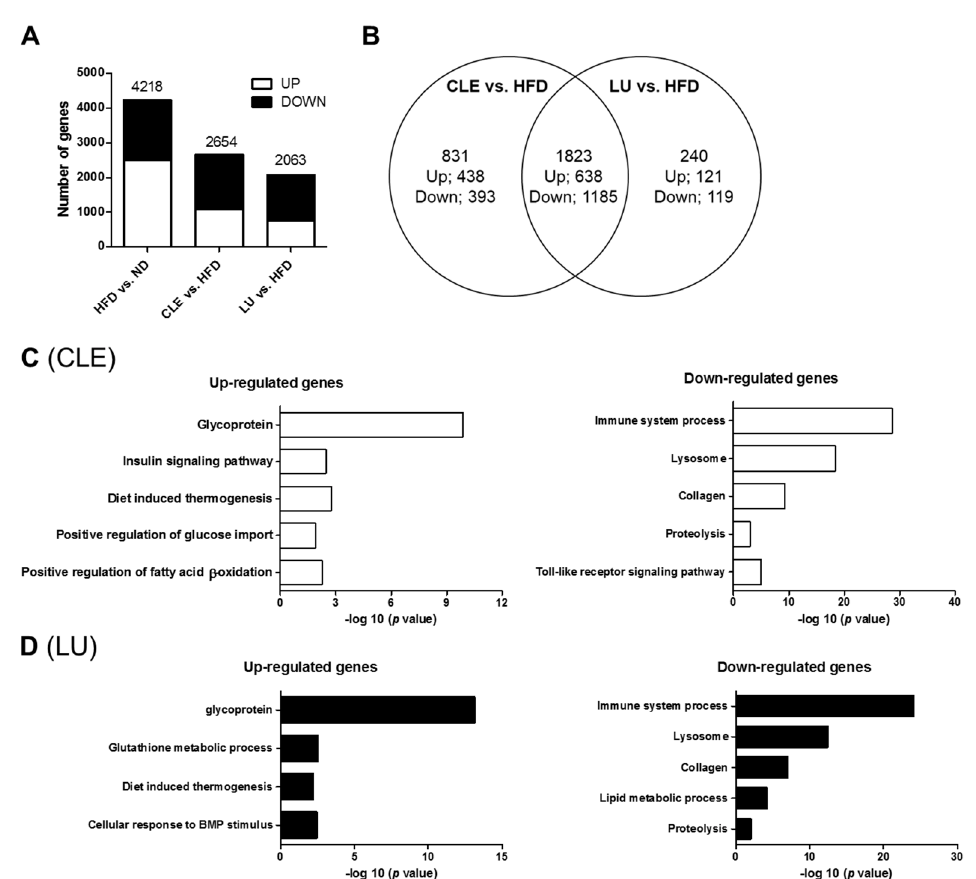
Figure 6. Transcriptional changes in eWAT of chrysanthemum leaf ethanol extract and luteolin groups compared to the high-fat diet group. ( A ) The numbers of up- or down-regulated genes in eWAT; ( B ) analysis of gene ontology in eWAT. Di ff erentially expressed genes based on HFD compared to ND, CLE and LU compared to HFD comparison at q < 0.05, fold change > 1.5; ( C , D ) functional annotation clustering of gene ontology in eWAT in the CLE group and LU group, respectively. ND, normal diet (AIN-76); HFD, high-fat diet (45% kcal from fat); CLE, HFD + chrysanthemum leaf ethanol extract (1.5%, w / w ); LU, HFD + luteolin (0.003% w / w , eWAT, epididymal adipose tissue).